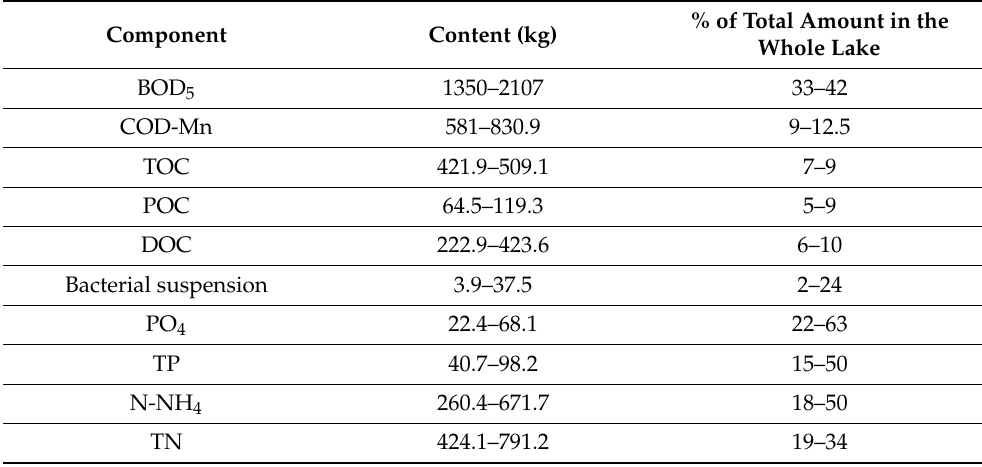
Table 3. The range of changes in the organic matter and biogenic element contents in the moni- molimnion of Lake Starodworskie (Tandyrak 2017 [9], with